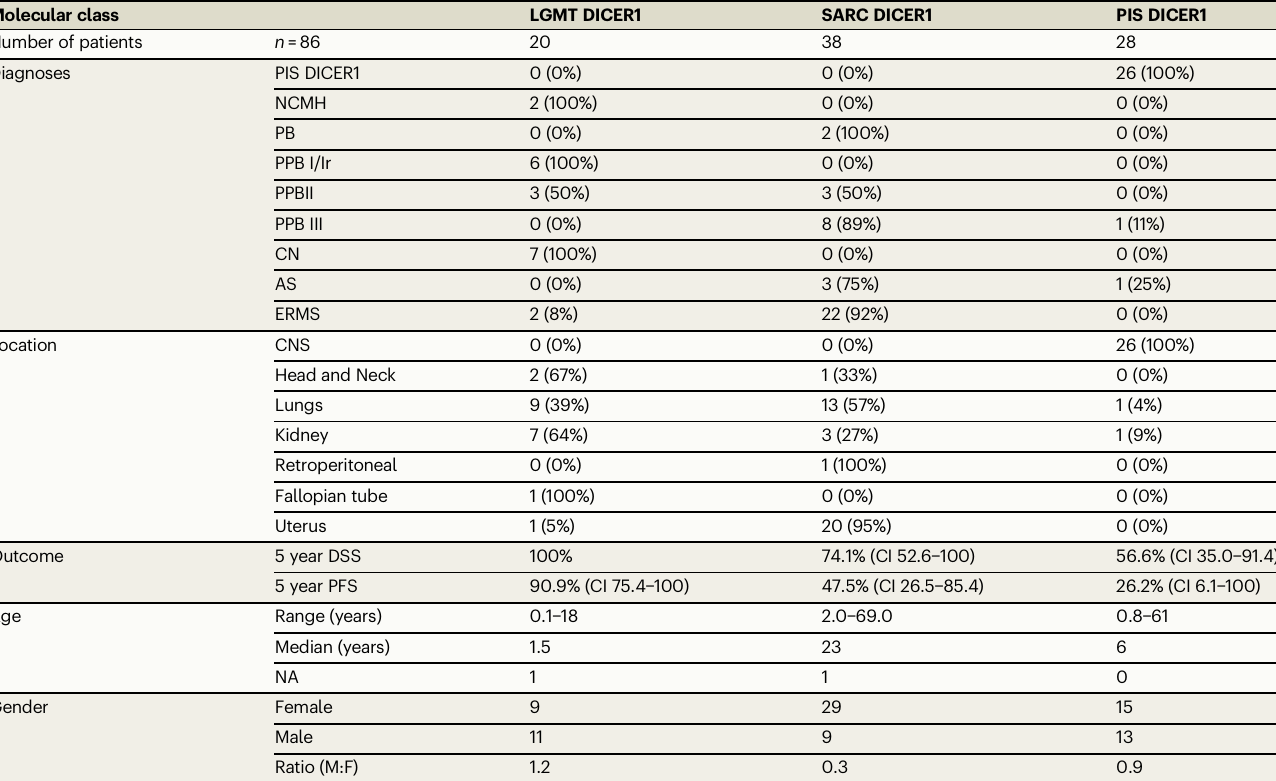
Table 1 | Clinical characteristics of mesenchymal tumors with DICER1 alteration according to LGMT DICER1, SARC DICER1 and PIS DICER1 cluster assignment ( n = 86) Molecular